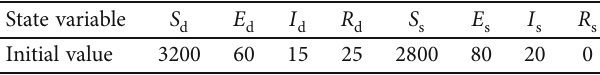
Table 5: Initial conditions used in the rabies model.